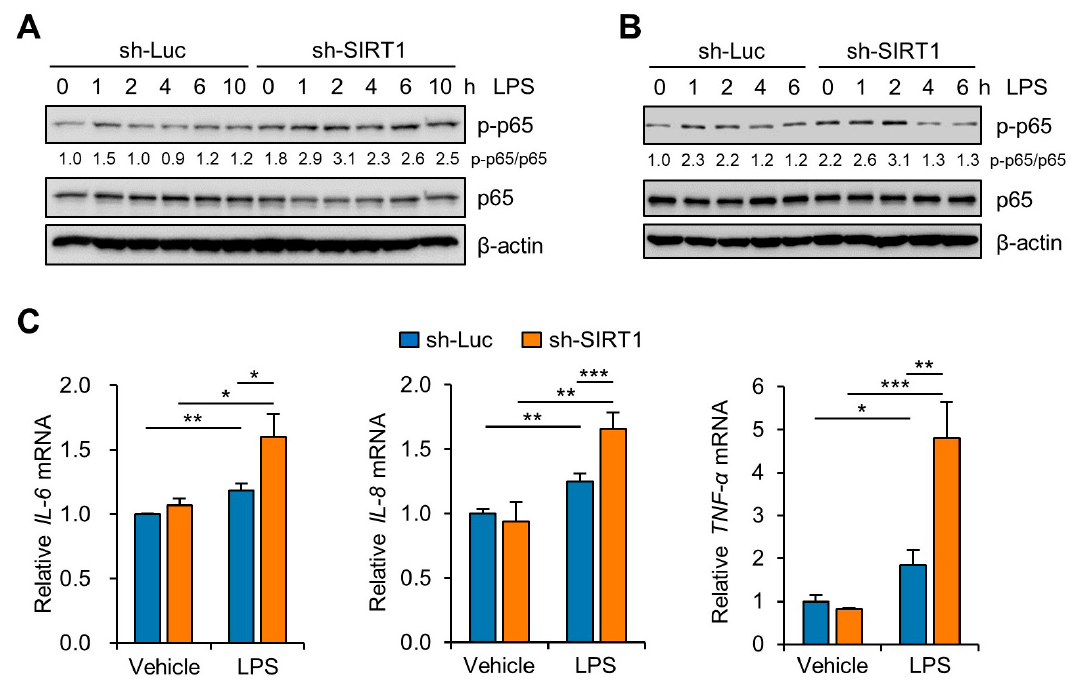
Figure 4. SIRT1 knockdown enhances LPS-induced inflammatory response in trophoblasts. ( A , B ) Sw.71 cells ( A ) and HTR-8 / SVneo cells ( B ) were infected with lentiviruses expressing shRNAs targeting luciferase (sh-Luc) or SIRT1 (sh-SIRT1) and were then treated with 200 ng / mL LPS for the indicated time. Cell lysates were immunoblotted with anti-p-p65 and anti-p65 antibodies. β -Actin served as a loading control. Numbers below the immunoblot bands indicate the fold changes normalized to the p65 bands. ( C ) Relative mRNA expression of IL-6, IL-8, and TNF- α in Sw.71 cells infected with sh-Luc or sh-SIRT1 lentivirus and treated with 200 ng / mL LPS for 6 h. Data are shown as mean ± SEM. Results are representative of at least three independent experiments. * p < 0.05; ** p < 0.01; *** p < 0.001 (Student’s t -test).